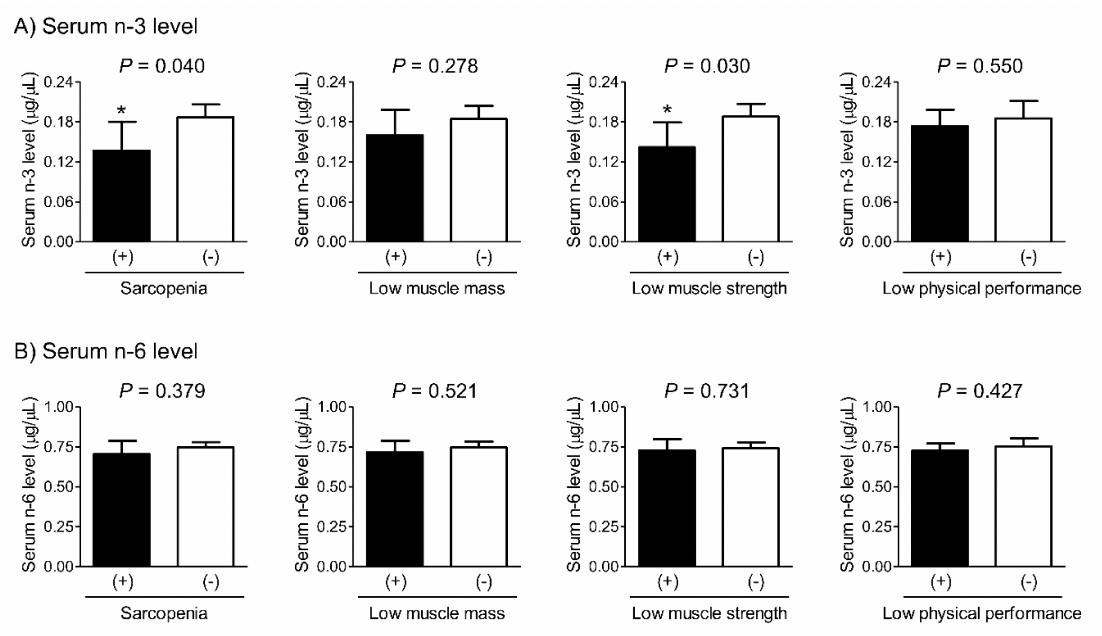
Figure 1. Di ff erences in serum levels of n -3 ( A ) and n -6 ( B ) fatty acids according to the status of sarcopenia and related parameters after adjusting for sex, age, and BMI. * indicates a statistically significant di ff erence from control. The estimated mean values with 95% confidence intervals were generated and compared using analysis of covariance. BMI, body mass